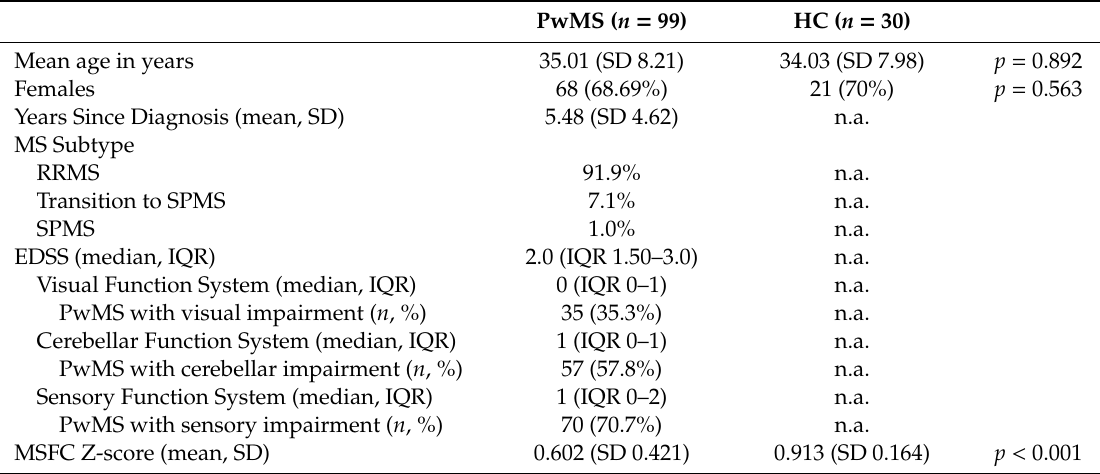
Table 1. General